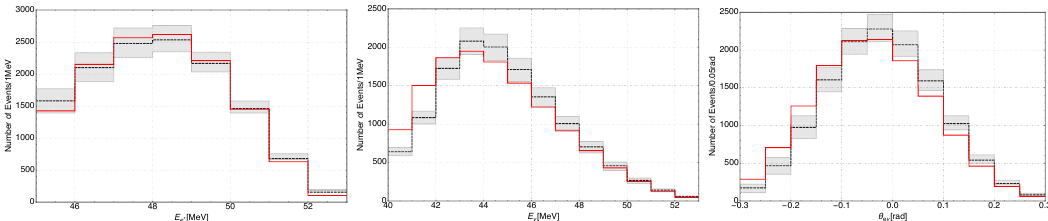
Figure 6 . Positron energy distribution, photon energy distribution, positron-photon polar angle acollinearity θ eγ distribution in RMD events using MEG’s kinematic cuts and detection efficien- cies. Red solid line from our simulation. For a check of validation, we show the central value of the expectation (Black dashed line) and the systematic uncertainty (Gray band) of Monte Carlo simulation given in ref. [14].